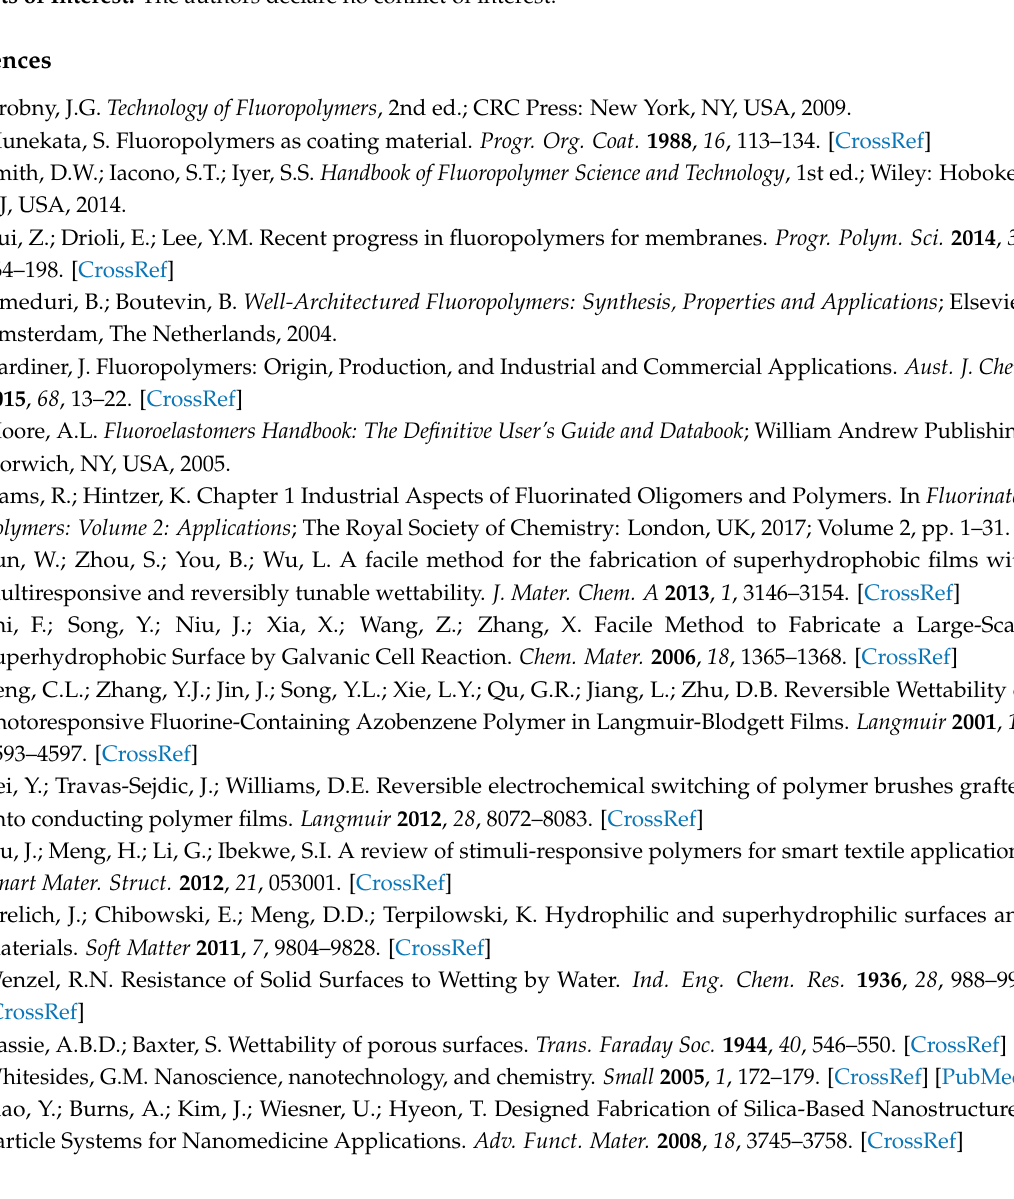
based core/shell particles; Figure S2: DLS measurements and TEM images of PS based core/shell particles; Figure S3: DSC thermogram of SiO 2 based core/shell particles; Figure S4: UV/Vis spectra of an opal film; Figure S5: Photograph of drops of water on opal and invers opal films; Figure S6: UV/Vis spectra of an inverse opal